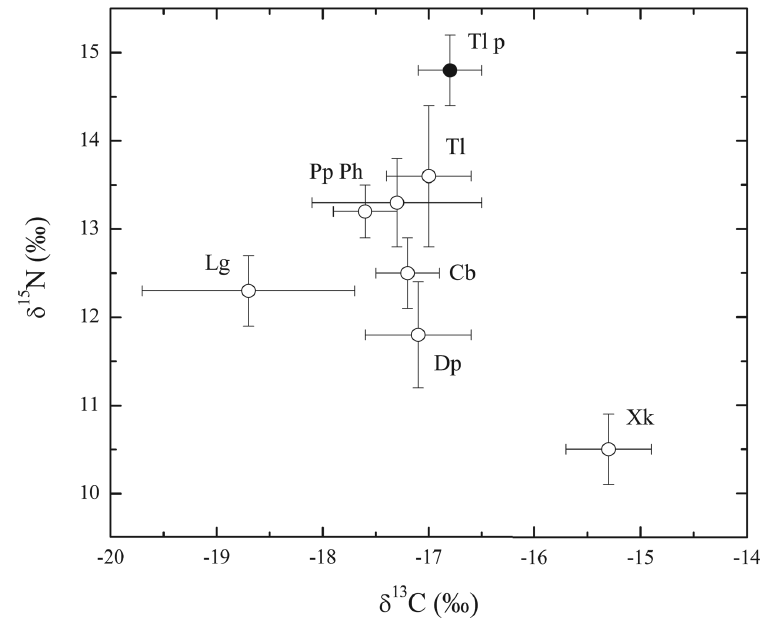
Figure 2 - Relationship between δ 13 C and δ 15 N in Trichiurus lepturus (adult specimens) and its preferred prey. Tl p: Trichiurus lepturus predator; Tl: T. lepturus prey; Cb: Chirocentrodon bleekerianus ; Lg: Lycengraulis grossidens ; Dp: Dorytheutis plei ; Xk: Xiphopenaeus kroyeri ; Pp: Peprilus paru ; and Ph: Pellona harroweri. Bars indicate the standard